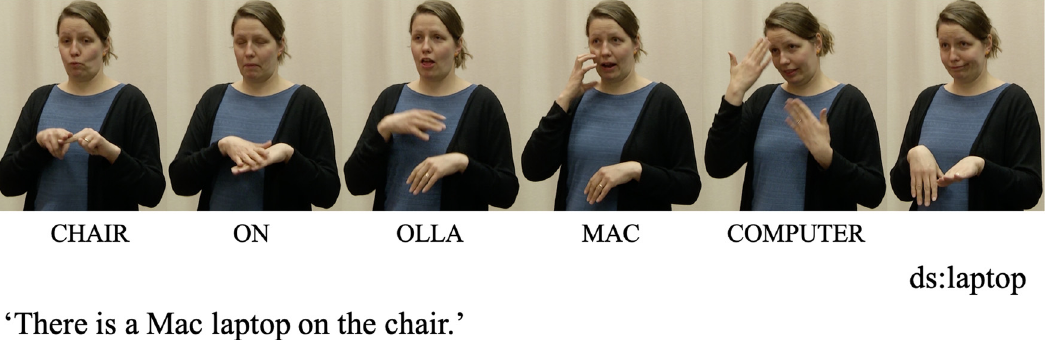
Figure 13: An example of a sequential strategy including an adposition and a new Figure entity depicted on H2.